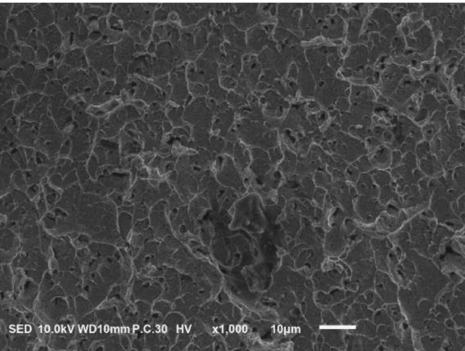
Figure 2. The SEM surface of PTU in dynamic cycles. There is no striation on the entire image.